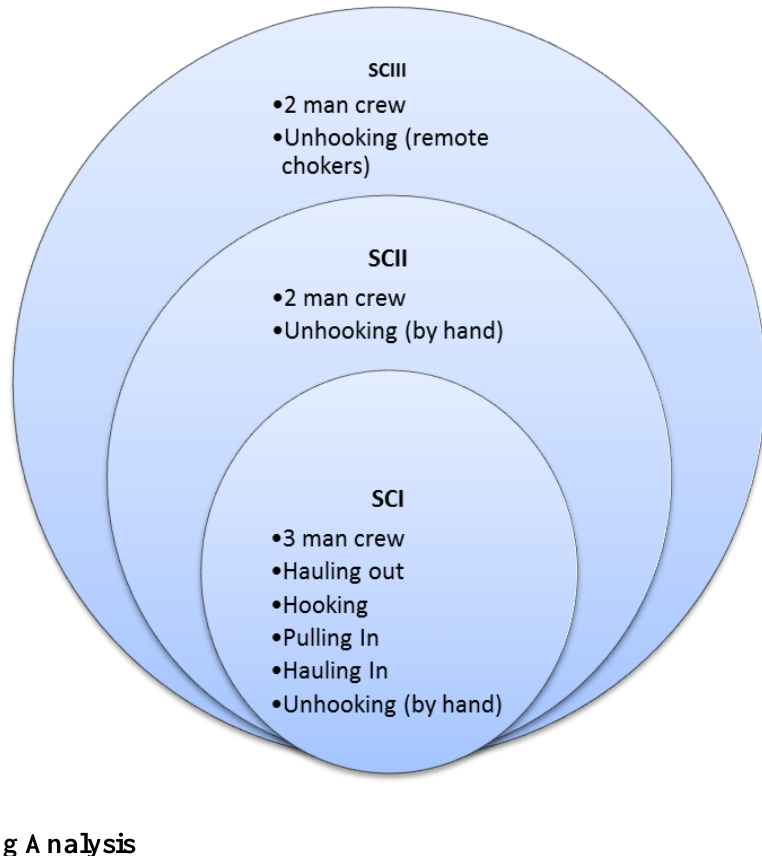
Figure 8. Flowchart describing the overlap of work elements for each